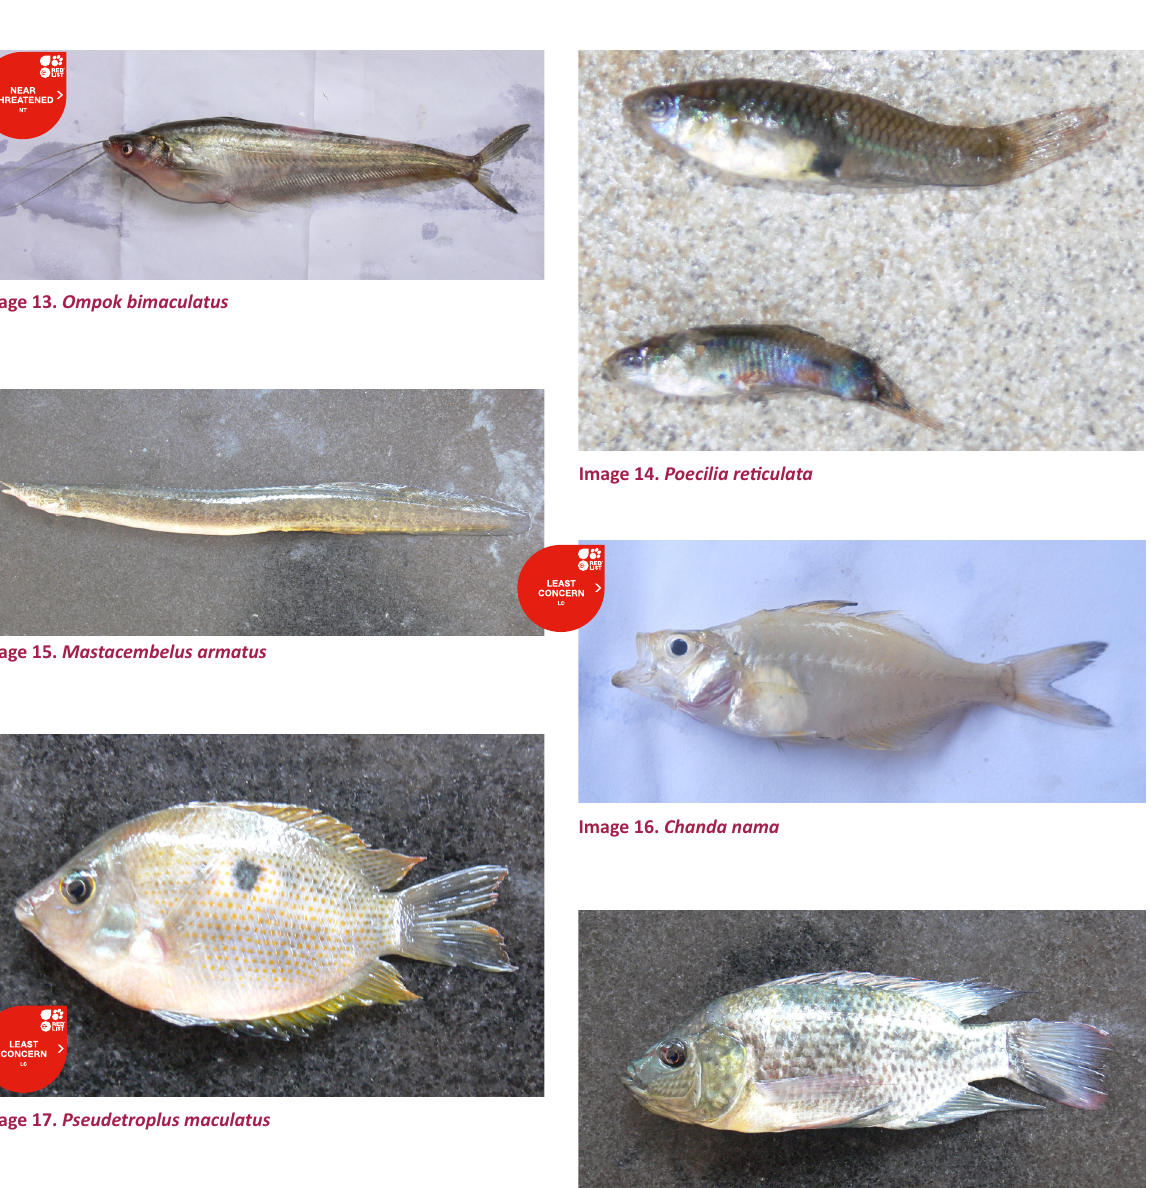
11. Schistura denisoni Image 12. Mystus vittatus